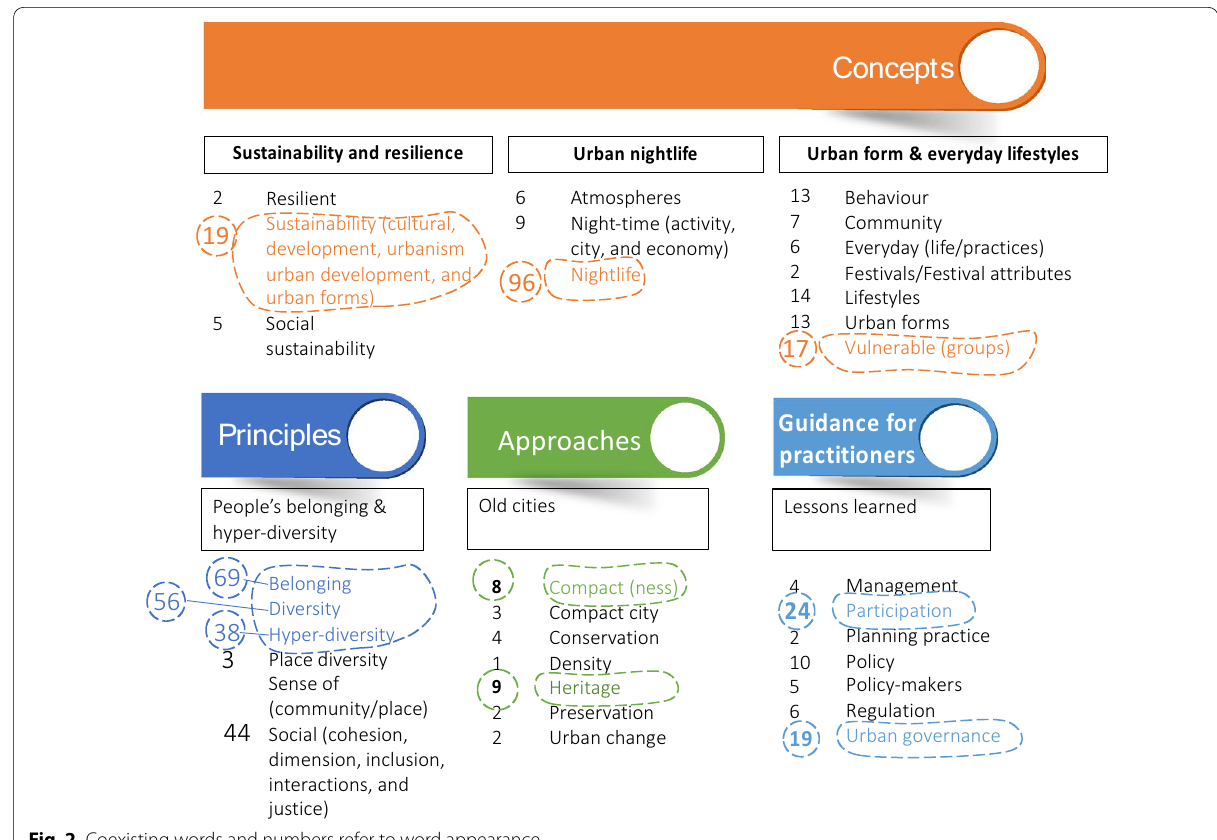
Fig. 2 Coexisting words and numbers refer to word